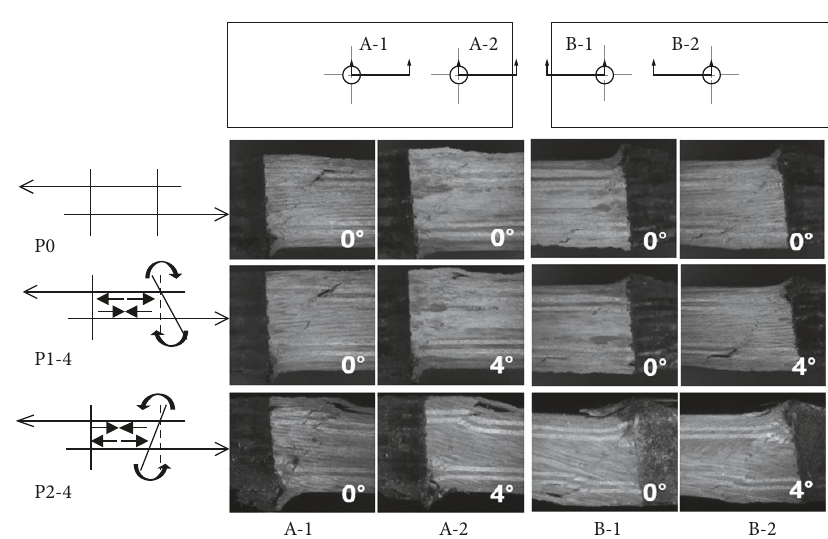
Figure 12: Hole damage pictures for specimen loaded up to 30